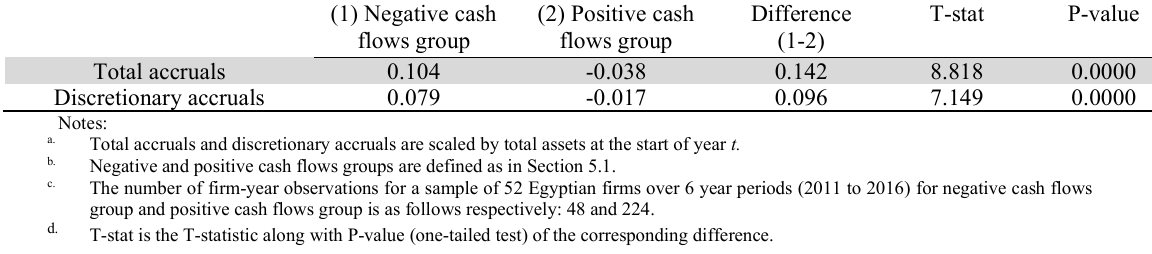
Mean accruals (total accruals and discretionary accruals) difference tests Accruals Mean (1) Negative cash flows group